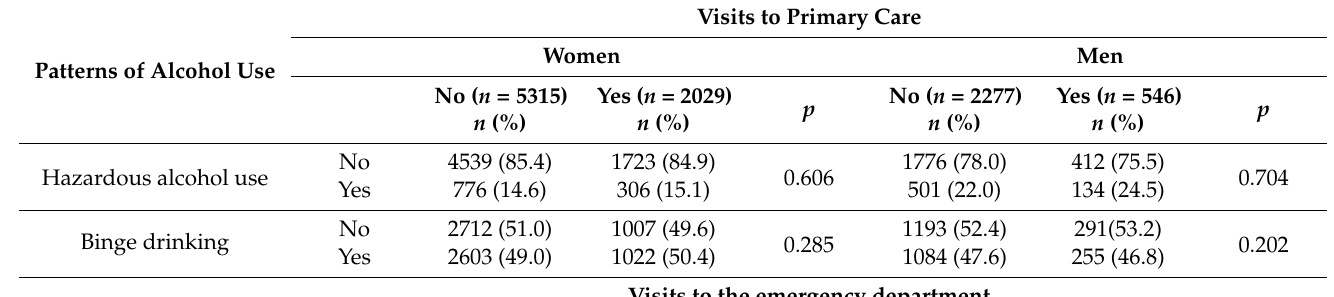
Table 4. Health services use among university students according to the pattern of alcohol use, stratified by sex.